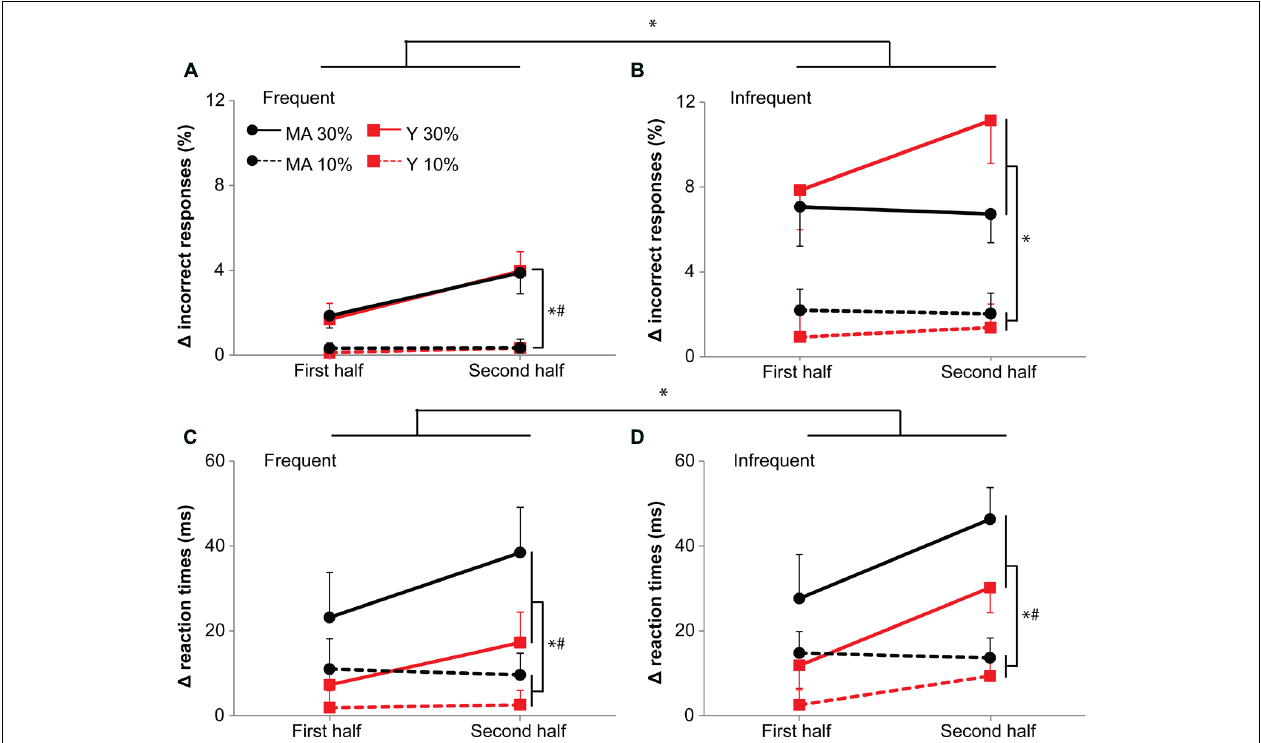
dashed lines for 10%-dual-task (10% cMVC). Data are shown for the first and second half of the task. Error bars represent SE. * shows main effects, # shows interaction effects. Please note the increase in errors (see, however; middle-aged subjects on infrequent stimuli) and reaction times with time for the